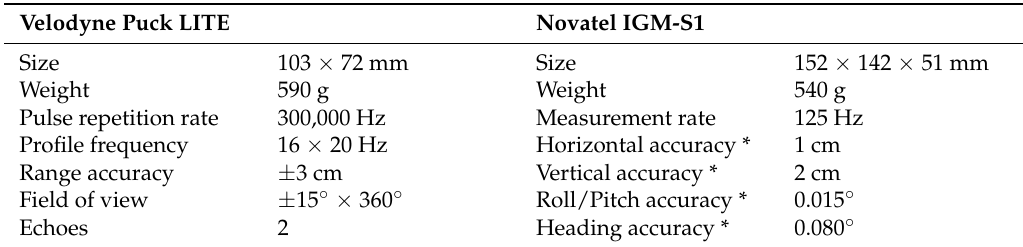
Table 2. Specifications of the system components.